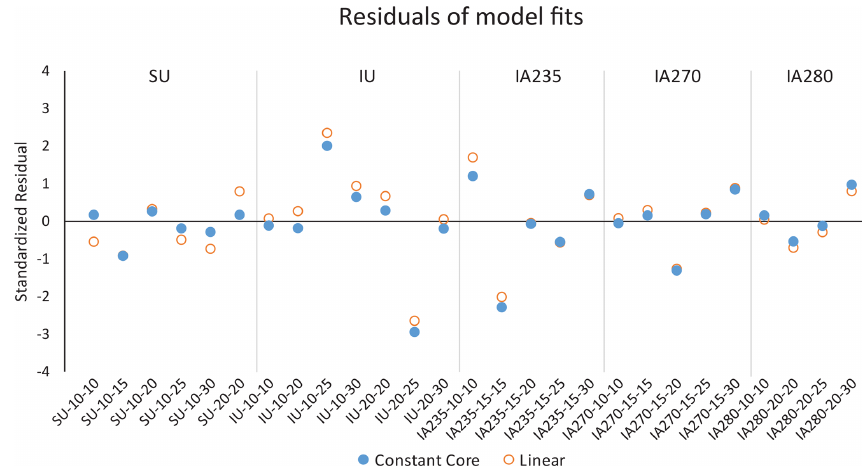
(cid:0) l − l (cid:1) /σ of model fits to each data set. est